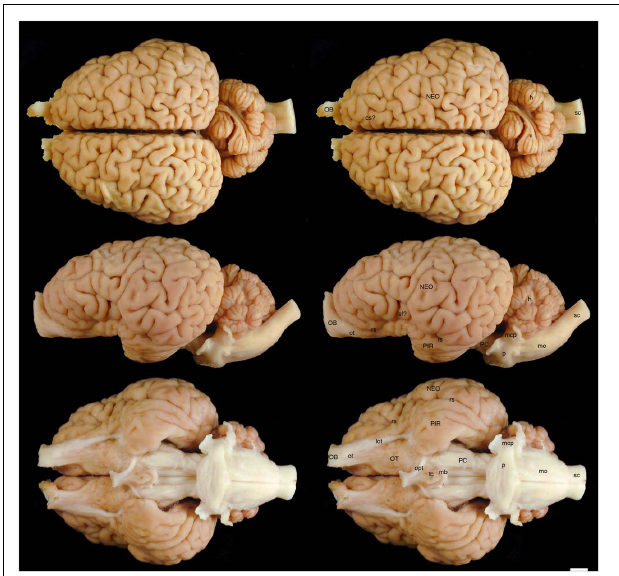
FIGURE 1 | Dorsal, lateral, and ventral views of the brain of the black rhinoceros ( Diceros bicornis ). Left column of images unlabelled. Right column of images, duplicates of those on the left with a number of specific structures labeled. Note the typically mammalian appearance of the brain in terms of the major anatomical subdivisions. Also note the very asymmetrical appearance of the vermal portion of the cerebellum. Scale bar = 1 cm. cs?, potential cruciate sulcus; h, hemispheric portion of cerebellum; lot, lateral olfactory tract; mb, mammillary bodies; mcp, middle cerebellar peduncle; mo, medulla oblongata; NEO, cerebral neocortex; OB, olfactory bulb; opt, optic tract; OT, olfactory tubercle; ot, olfactory tract; p, pons; PC, cerebral peduncle; PIR, piriform cortex; rs, rhinal sulcus; sc, spinal cord; sf?, potential sylvian fissure; tc, tuber cinereum; v, vermal portion of